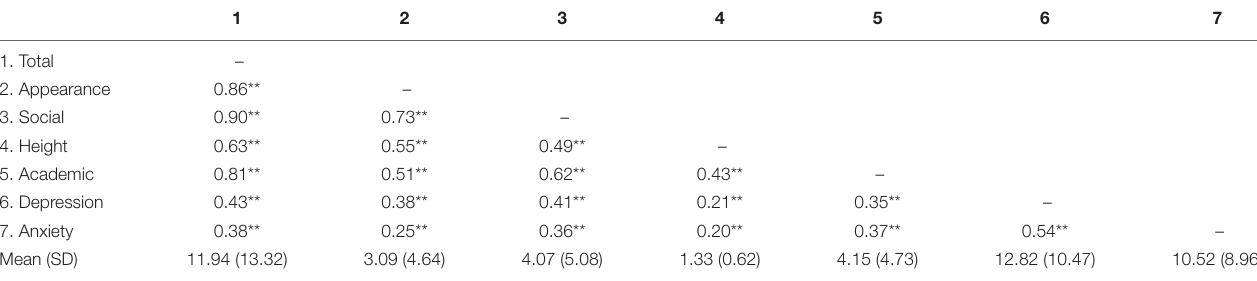
TABLE 4 | Pearson correlation, mean, and SD of TR-Q and its subscales with anxiety and depression ( N =